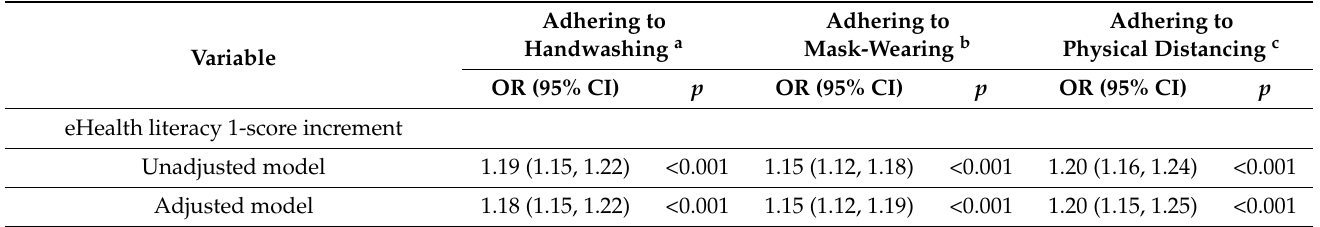
Table 4. Associations of eHealth literacy with preventive behaviors among nursing students (n =